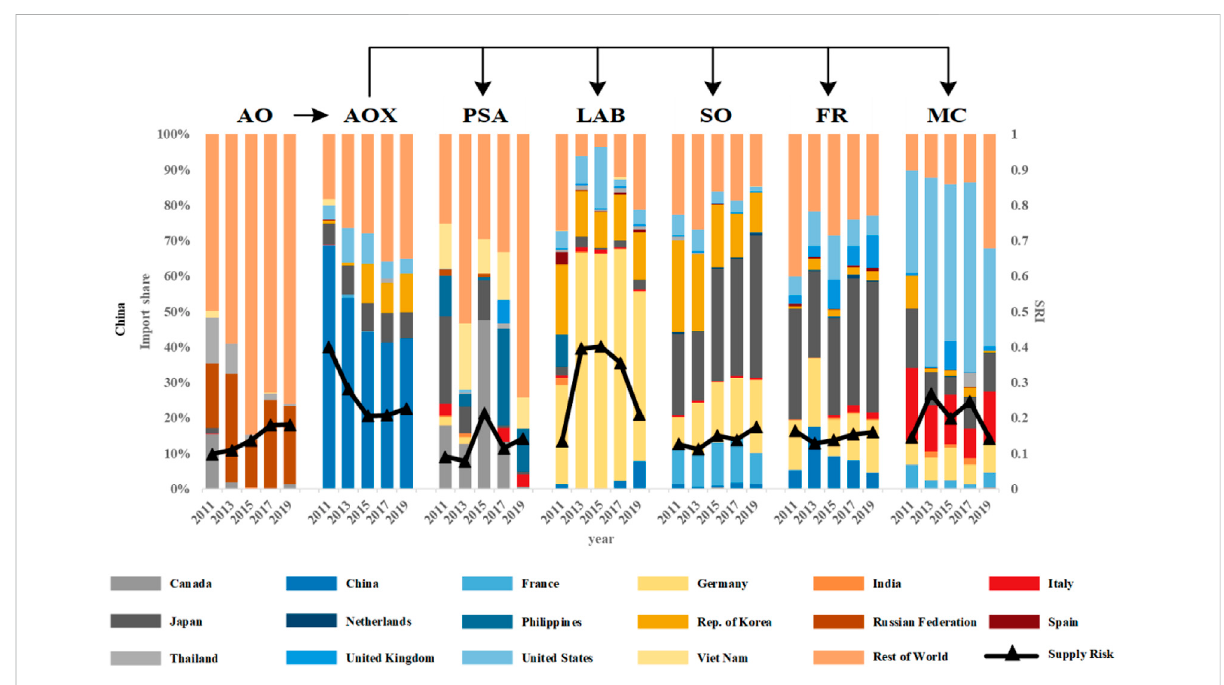
Import structures and risks of key commodities in the antimony industry chain in